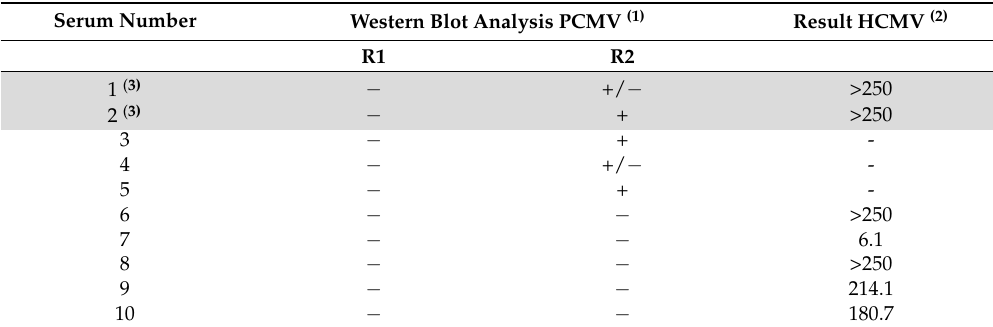
Table 2. Testing human sera for porcine cytomegalovirus (PCMV) and human cytomegalovirus (HCMV) by Western blot analysis.